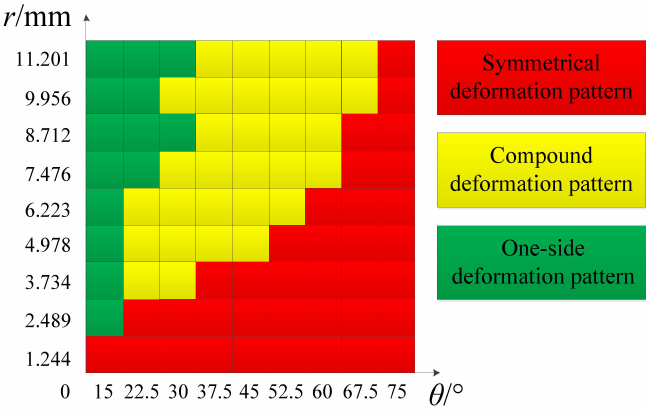
Figure 9. Distribution of deformation modes in the x-direction.